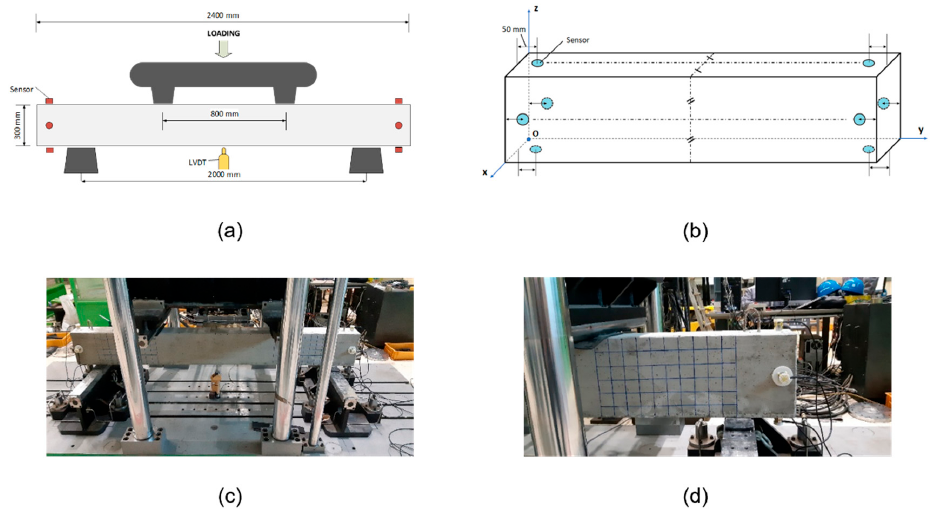
Figure 1. Illustration of the RC beam under a four-point bending test: ( a ) Loading and LDVT placement, ( b ) sensor placement, ( c ) pictorial of the test setup, ( d ) pictorial of the gridded specimen. The detailed information of this experiment is listed, in Table 1: Table 1. Experimental specifications.